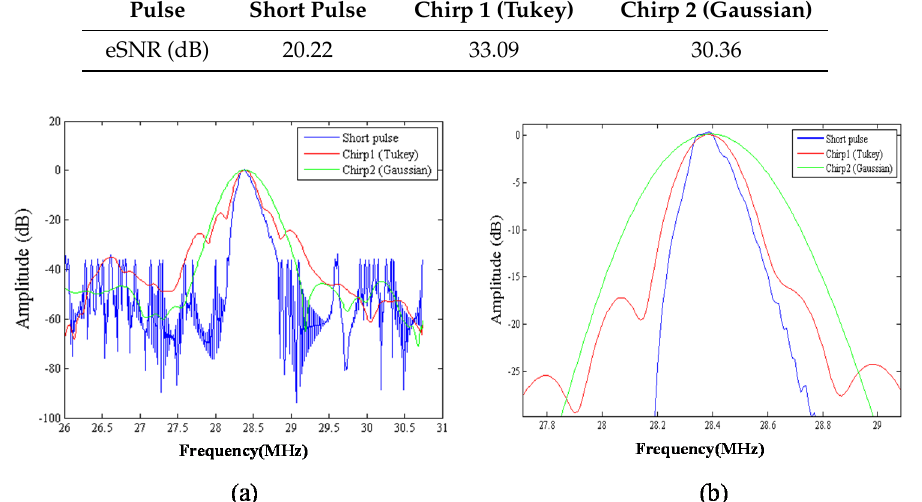
Figure 28. ( a ) Comparison of envelopes of short pulse, chirp 1 scheme and chirp 2 scheme with 20 cycles of pulse length; and ( b ) the detail in ( a ) from 27 to 29 MHz. 20 cycles of pulse length; and ( b ) the detail in ( a ) from 27 to 29